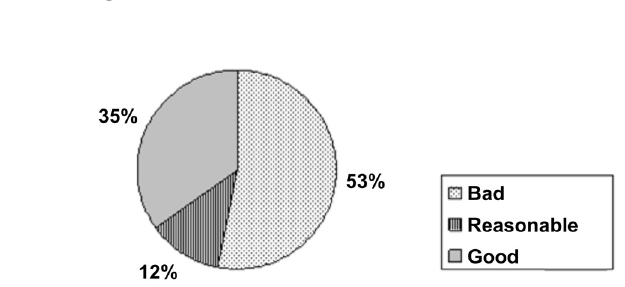
FIGURA 1 - Municipalities distribution as a function of the percentage of physical stock corresponding to records in their stock control instrument. Regional Management of Health of Belo Horizonte, MG,